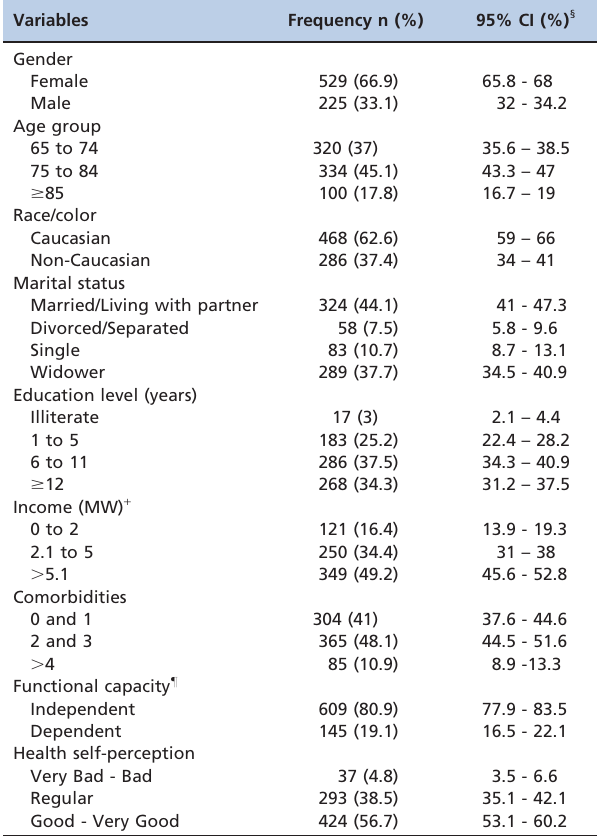
Table 1 - Sociodemographic and health characteristics